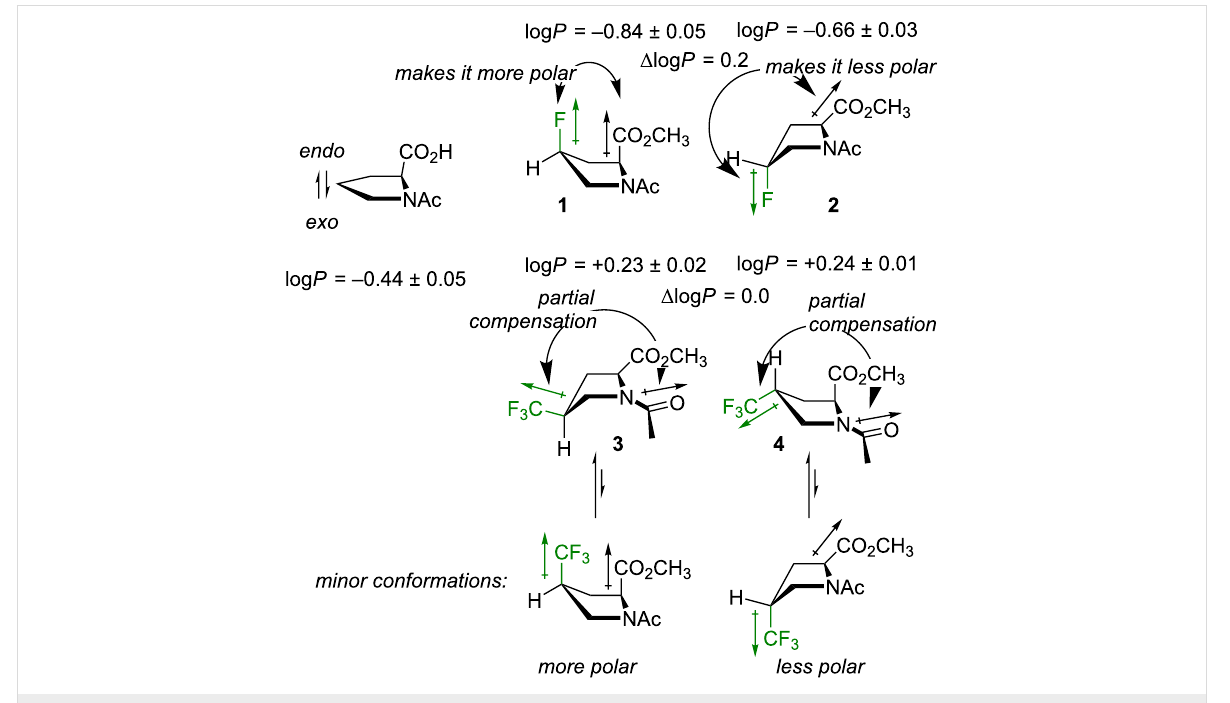
Figure 7: The lipophilicity data of the model compounds.